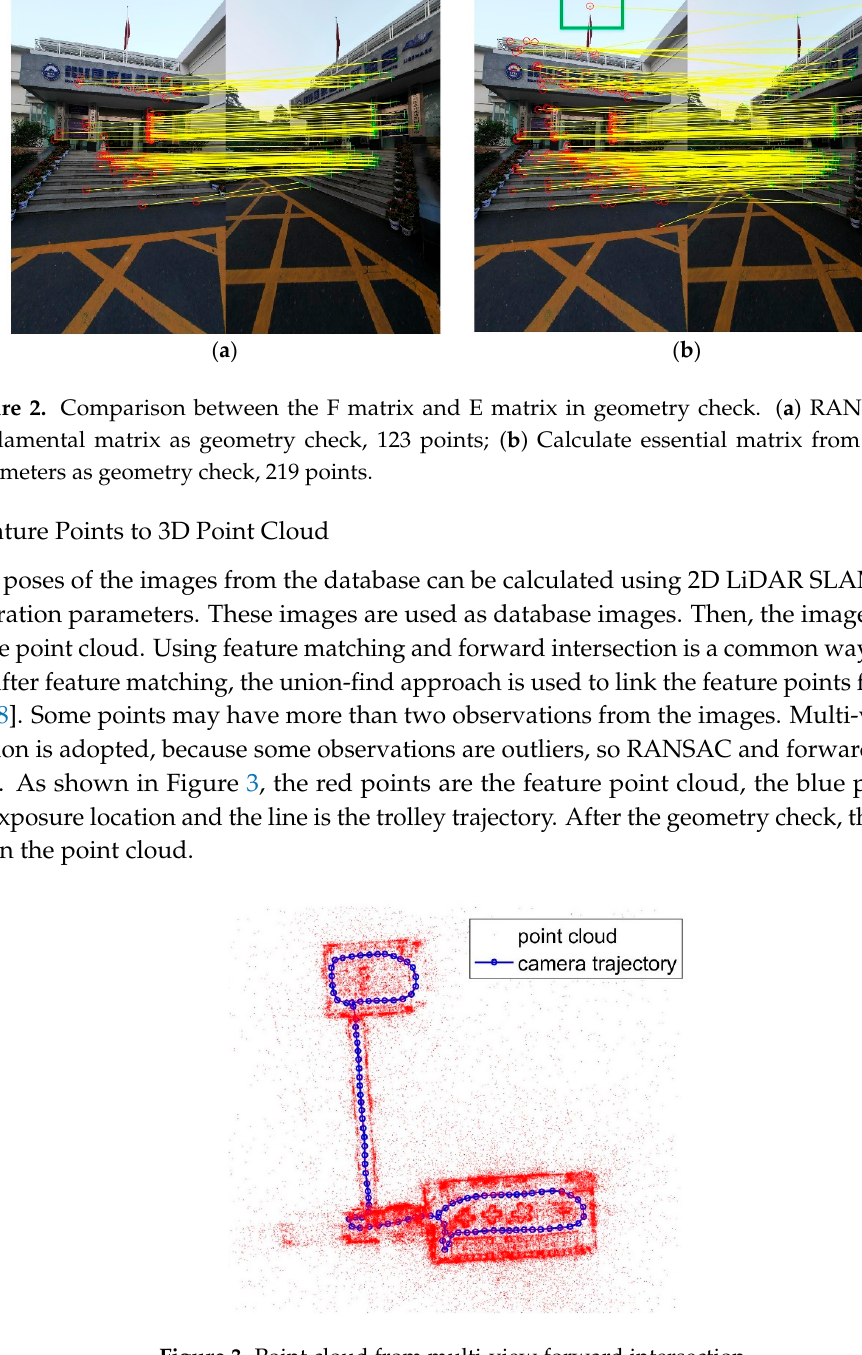
4 of 21 Figure 1. Workflow of database Image processing. Before building an inverted file, a visual word vocabulary is needed [16]. In order to improve the computer efficiency of clustering, hierarchical k-means is used to train the visual words [47]. After training, the hamming embedding method is used to build the inverted file [29].